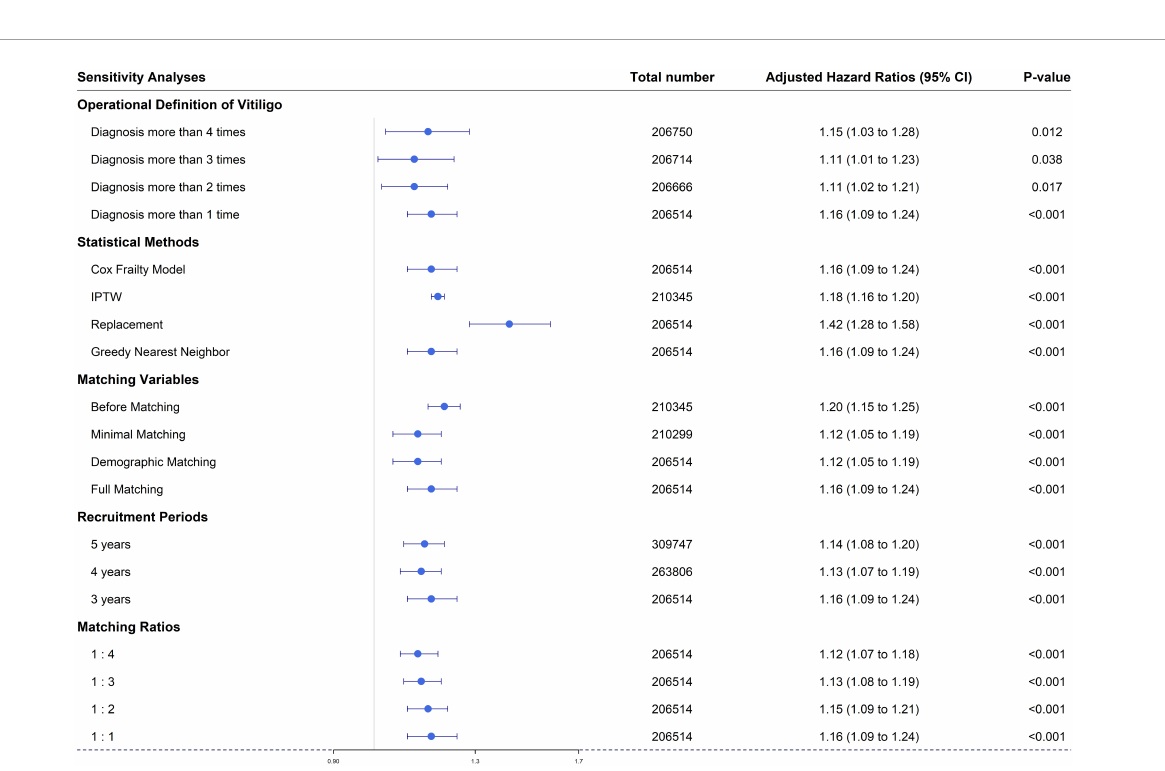
FIGURE4 Sensitivity analyses regarding: (1) operational definitions of vitiligo, (2) statistical methods, (3) matching variables, (4) recruitment periods, and (5) matching